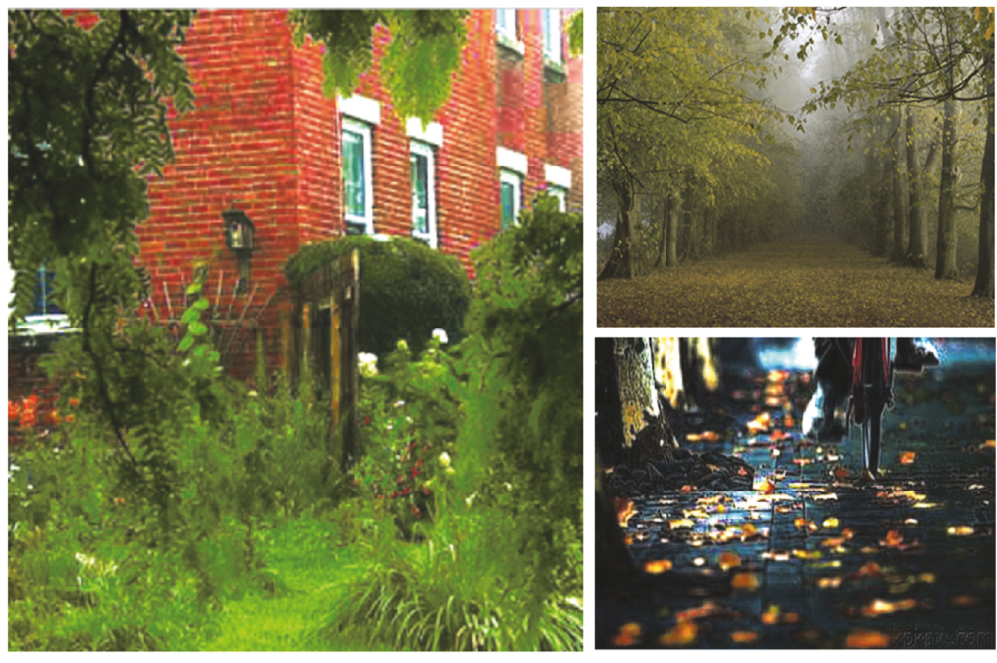
Figure 2: Clearness images restored from original images without obvious light color areas.